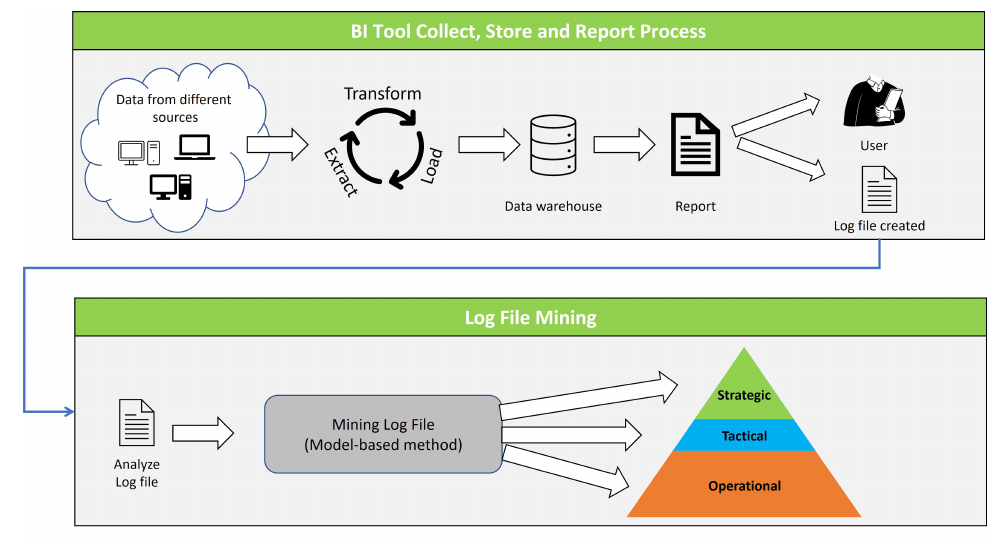
Figure 2. Framework used for mining at the decision-making Level.